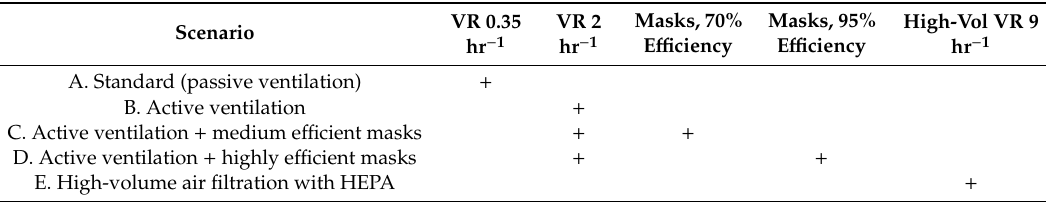
Table 3. Scenarios of mitigation measures. VR is ventilation rate with outside air, or by high-volume HEPA filtering (last